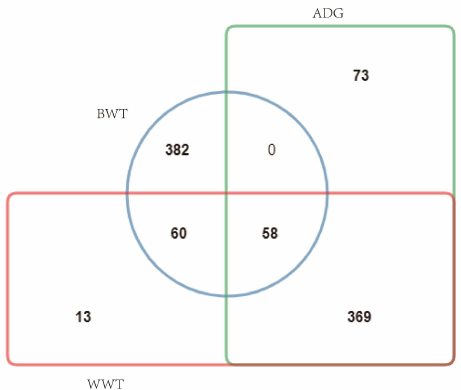
Figure 2. Venn network about 3 traits of lambs in top 500 EBV.